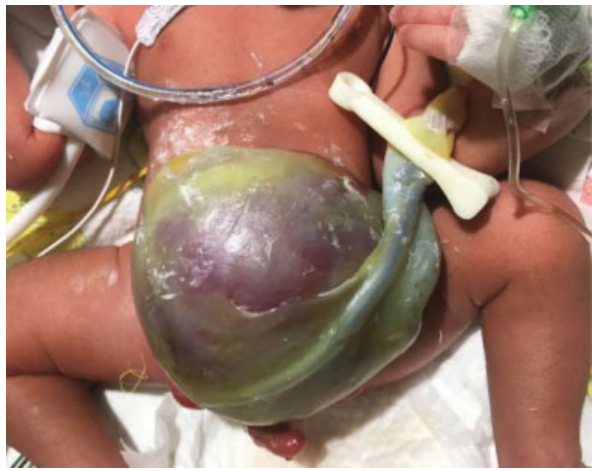
Fig. 2 Day of life 1: Large liver containing